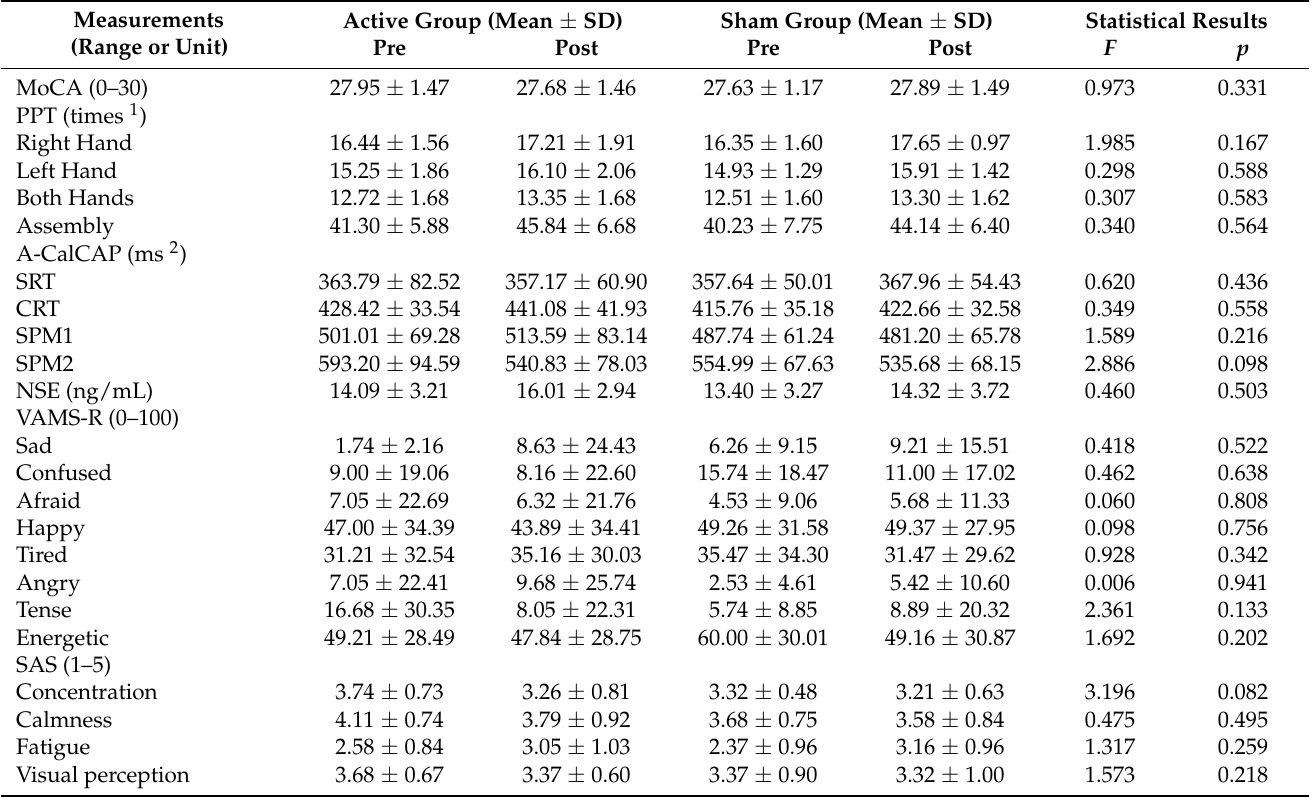
Table 1. The statistical results of neurological and neuropsychological measurements.